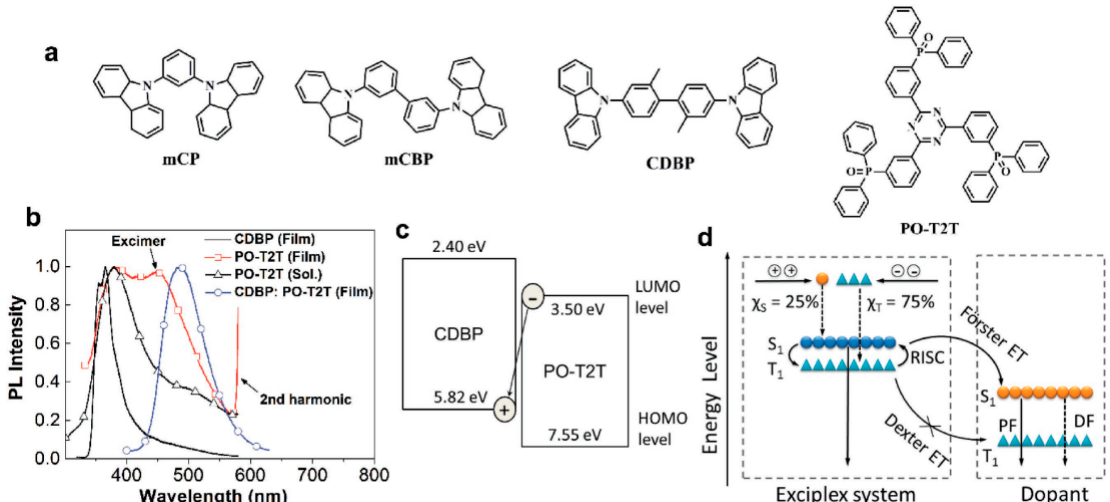
Figure 7. ( a ) Molecular structures of mCP, mCBP, CDBP as well as PO-T2T. ( b ) The PL spectra for CDBP film (solid line), PO-T2T film (line with square), PO-T2T solution (line with triangle), and CDBP: PO-T2T co-deposited film (line with circle). ( c ) The exciplex light generated from the donor CDBP and acceptor PO-T2T. ( d ) Physical processes in the exciplex host-dopant systems. ET, PF and DF are energy transfer, prompt fl uorescence, and delayed fl uorescence, respectively [172].